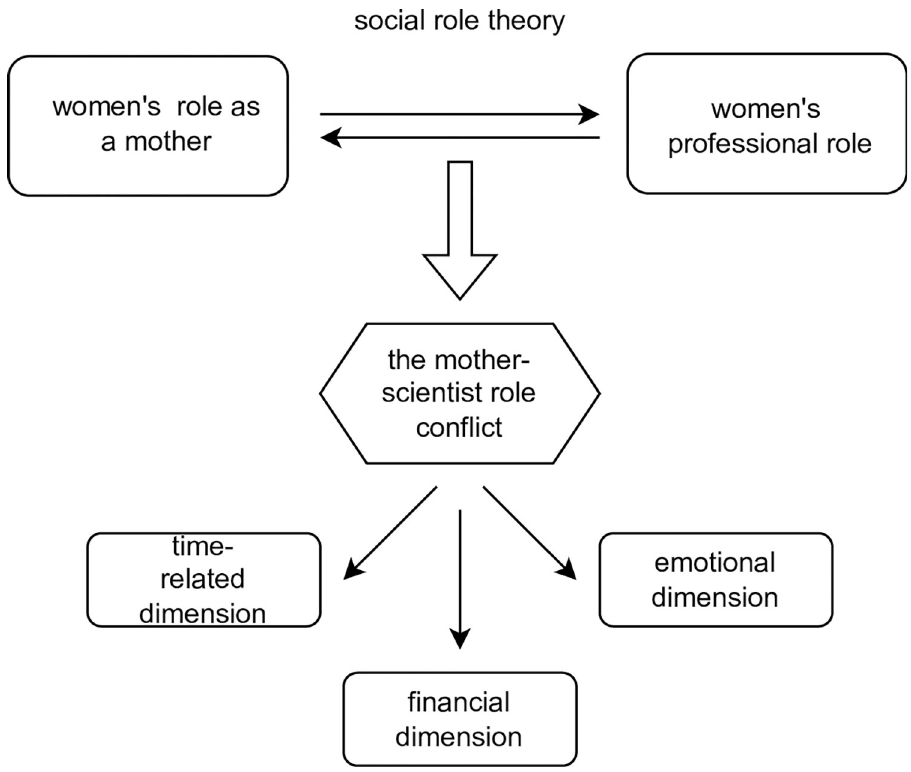
Fig 1. Theoretical framework for the